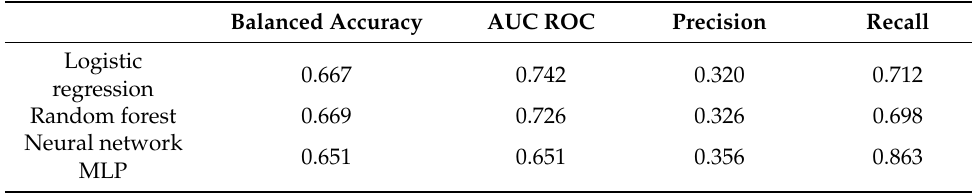
Table 5. Results of the different metrics according to the method of analysis. Balanced